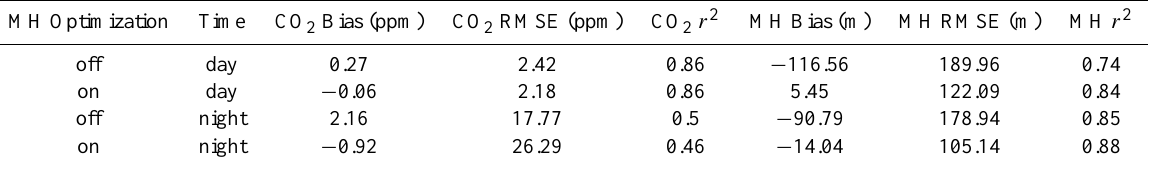
Table 4. Comparison of CO 2 and MH model to model differences shown for Cabauw. The differences were calculated by subtracting the simulations using YSU PBL scheme from the ones using MYJ PBL scheme for each experiment, i.e. with and without MH optimization respectively. Day denotes hours 10:00–12:00UTC and night